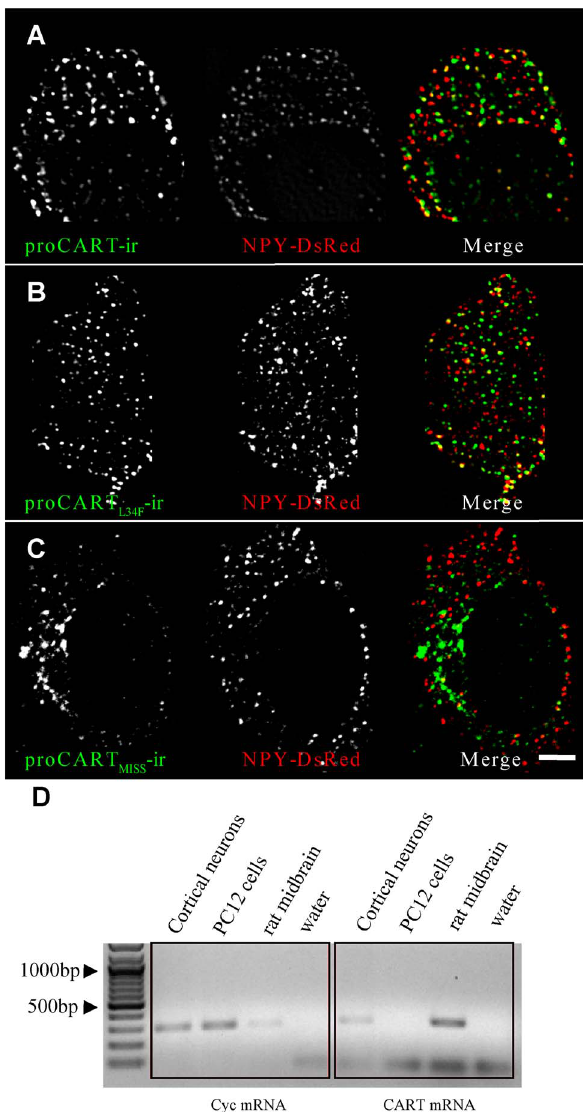
Figure 4. proCART and proCART L34F , but not proCART MISS colocalized with NPY-DsRed. proCART species without EGFP were cotransfected in PC12 cells with NPY-DsREd expressing vector and detected with an antiCART specific polyclonal rabbit antibody. (A) proCART and (B) proCART L34F showed a punctate pattern and both colocalized with NPY-DsRed. However, (C) proCART MISS showed a perinuclear pattern and did not colocalize with NPY-DsRed. (D) RT-PCR for CART mRNA in rat primary cortical neurons, PC12 cells and rat midbrain at the level of the Edinger-Westphal nucleus. Total RNA was extracted with Trizol and 0.5 m g of each RNA was used for each RT-PCR. A set of specific primers (listed in Table S1) to amplify a 322 bp fragment of pre-proCART mRNA were used. Cyclophilin (Cyc) mRNA was also amplified as a control.